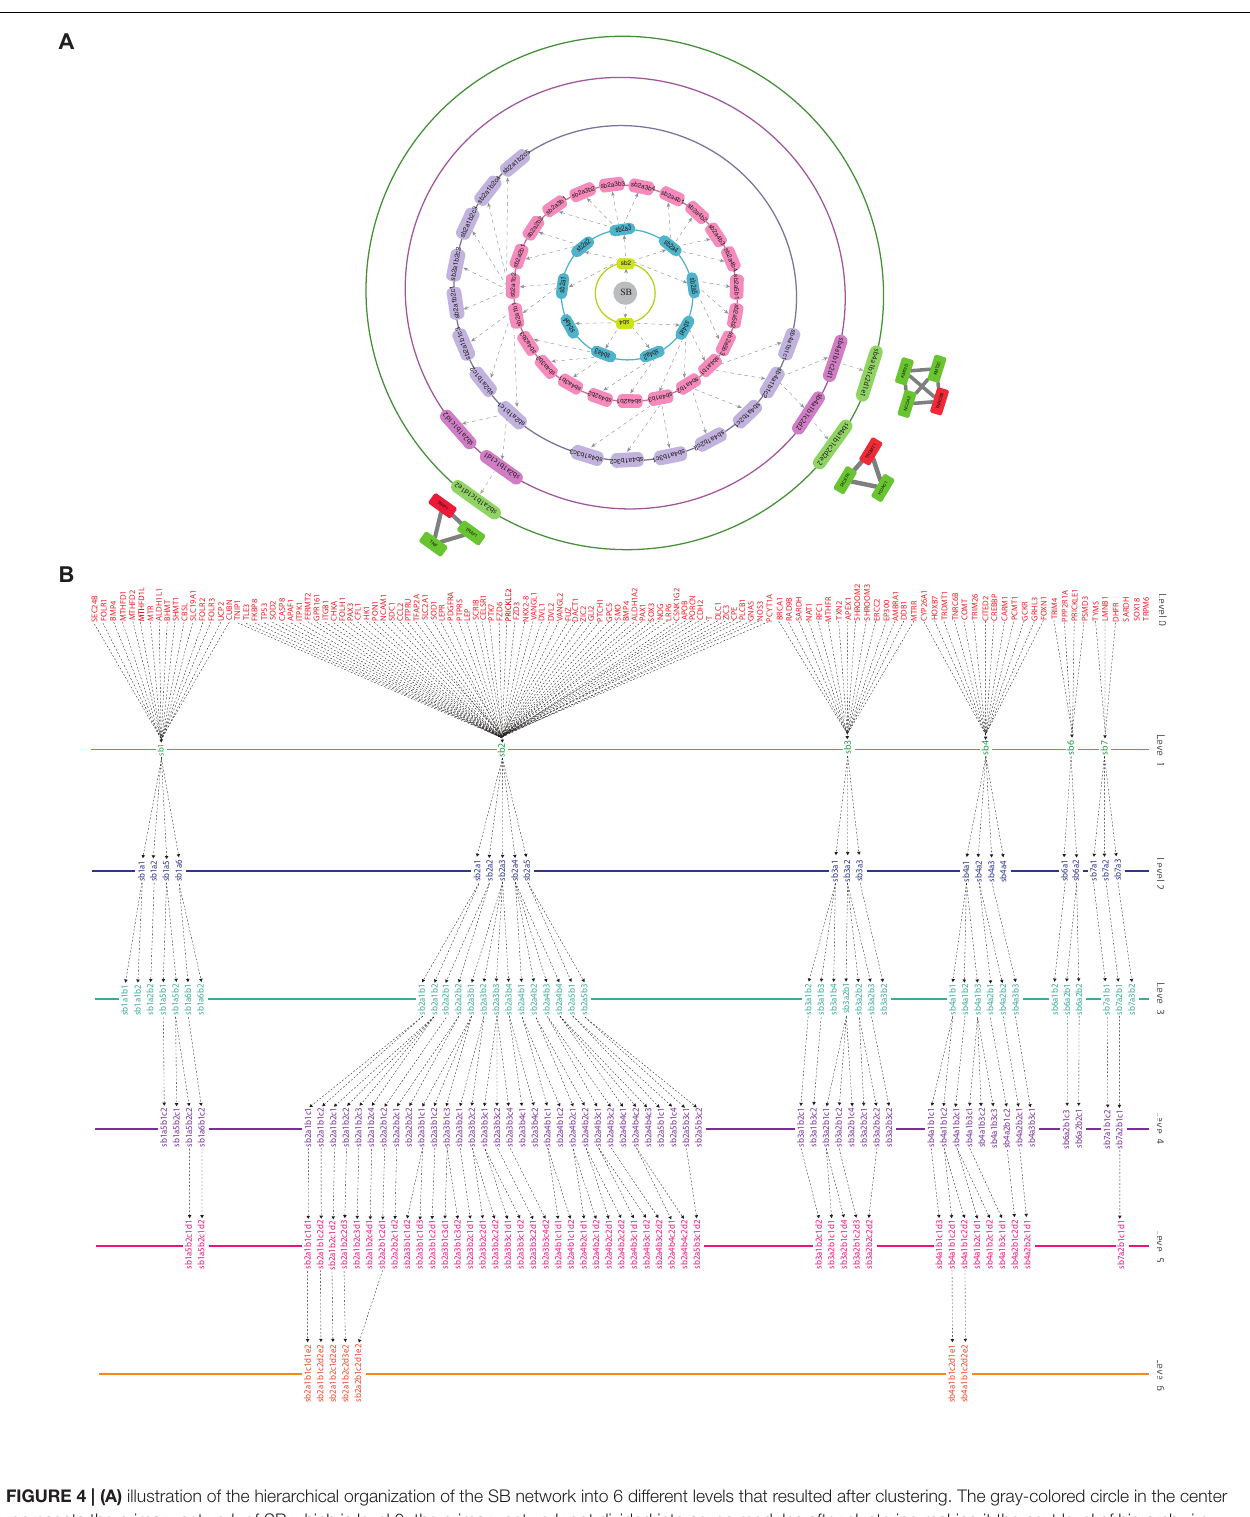
Frontiers in Genetics |